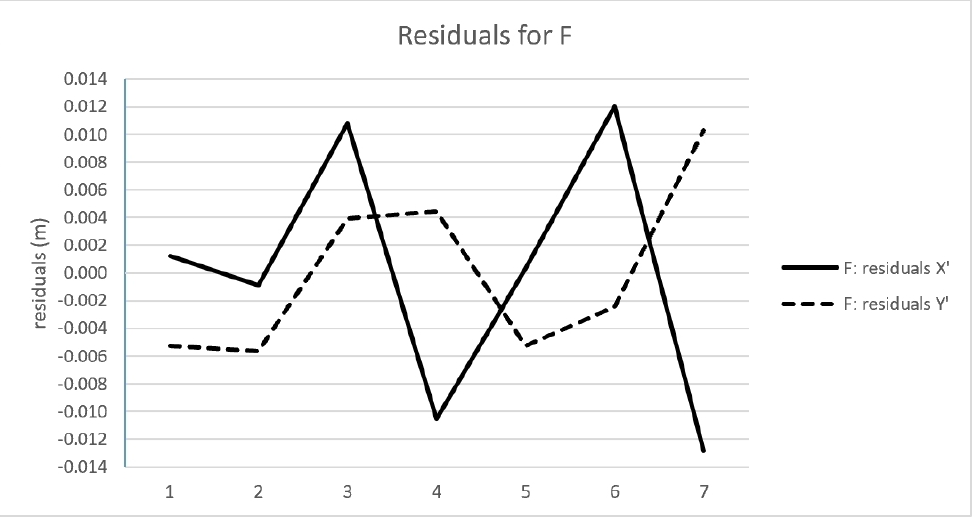
Figure 10. Residuals in meters for the different targets on the